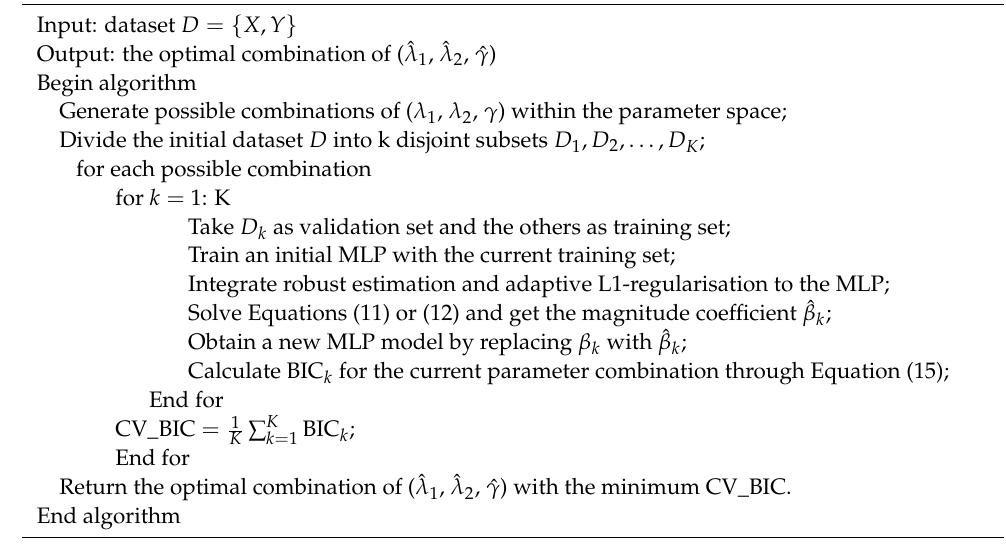
Algorithm 1. Determination of 𝜆(cid:4632) (cid:2869) and 𝜆(cid:4632) (cid:2870) via K-fold CV.